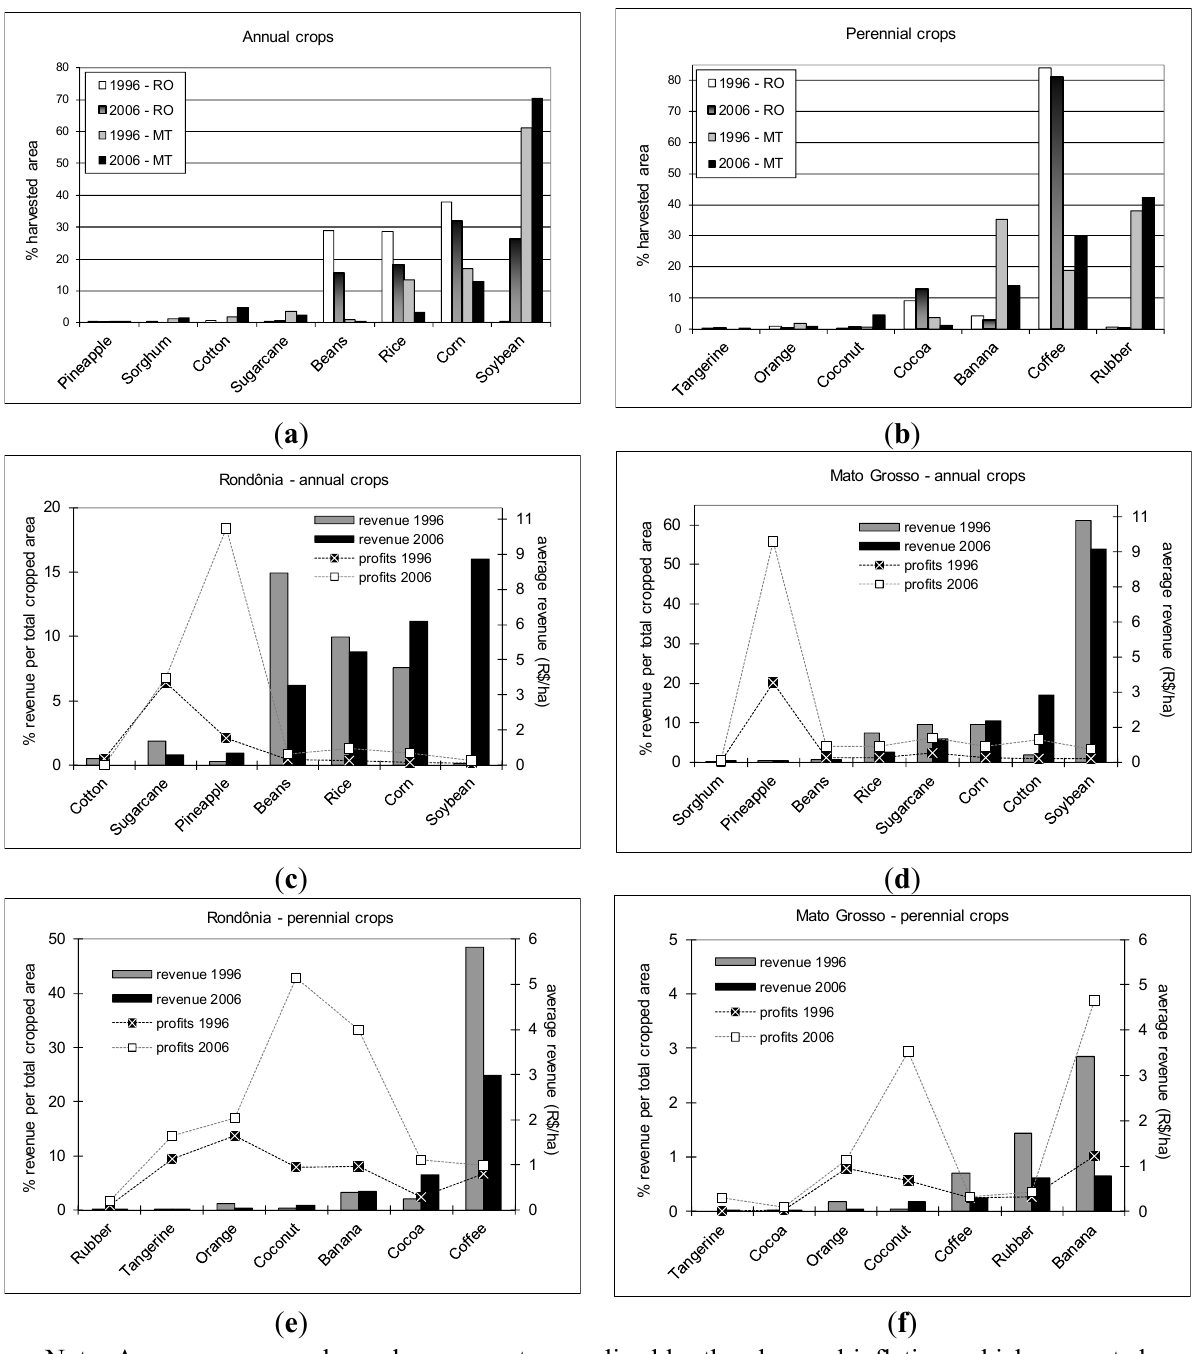
Figure 3. ( a , b ) Census statistics from 1996 and 2006 considering the 95% most significant crops in terms of total cropped area per type of crop (annual of perennial) in Rondônia and Mato Grosso; ( c – f ) The fraction of revenue and the average revenue of relevant annual or perennial crops that accounted for 95% of total harvested area in both census